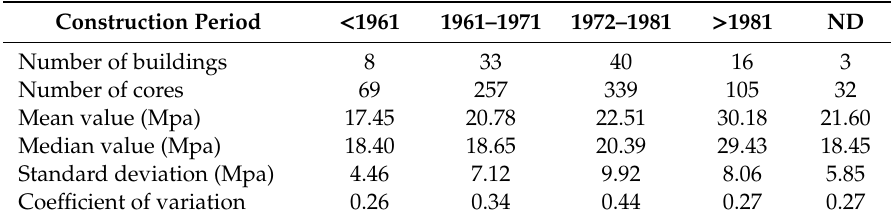
Table 4. Statistical data of the subset of concrete strength values regarding buildings with at least five cores.